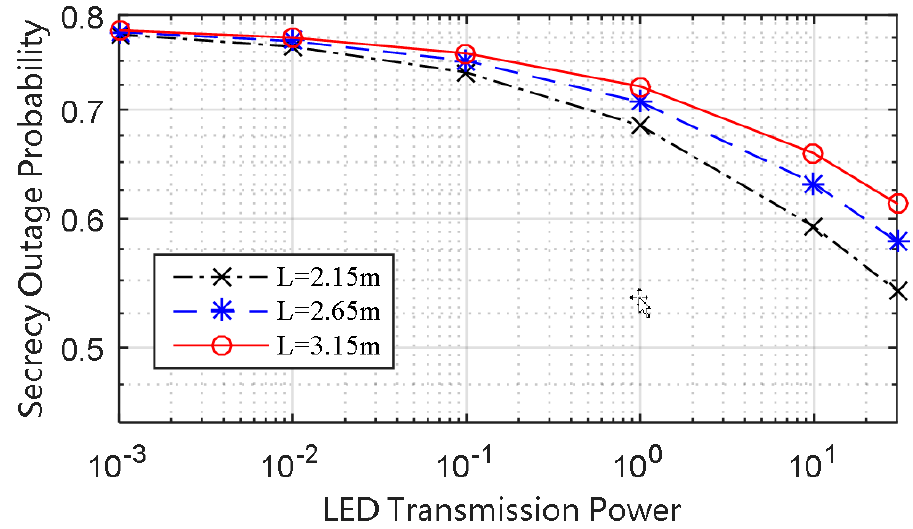
Figure 4. SOP of the strong user versus the distance from the LED transmitting plane to the photodiode (PD) receiving plane.